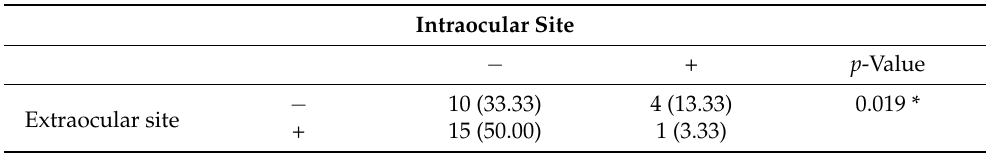
Table 1. Comparison of microbiological test results between microbial sampling of the extraocular and intraocular corneoscleral rims.